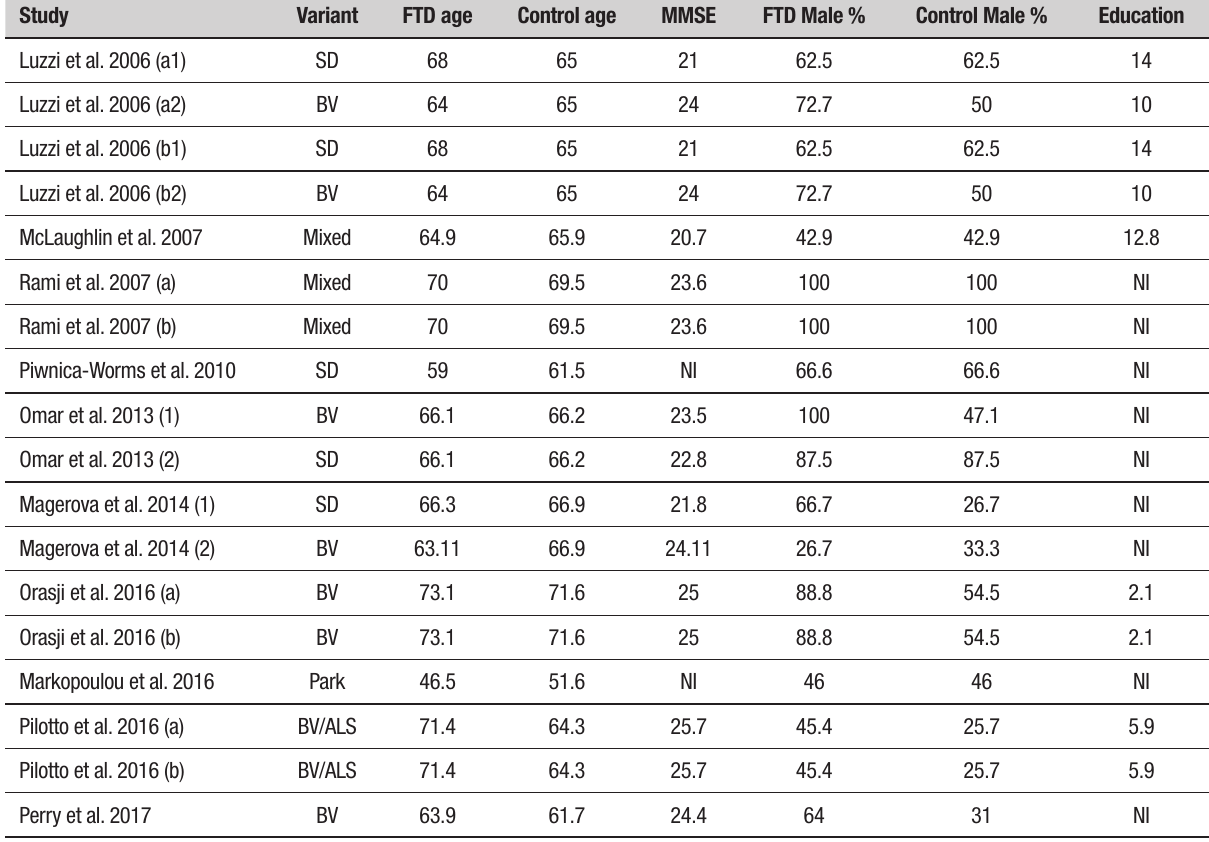
Table 2. Characteristics of samples.